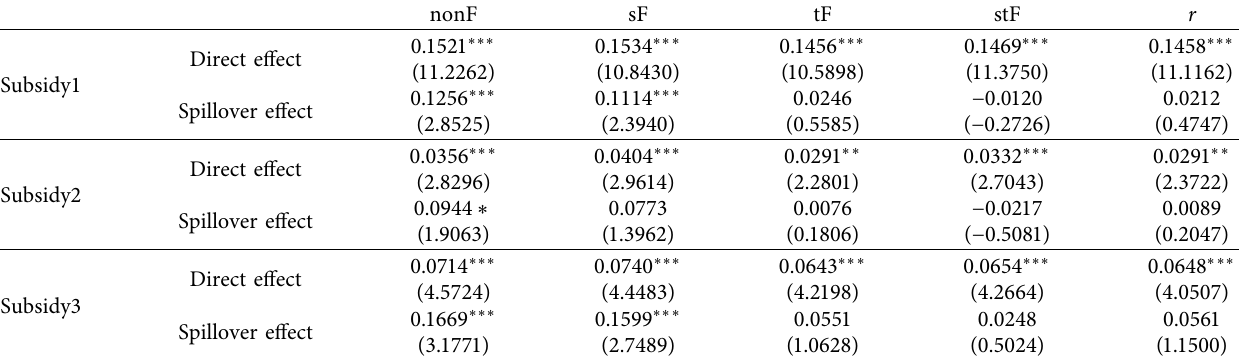
Table 8: Results of the impact mechanism test: impact on innovation support.